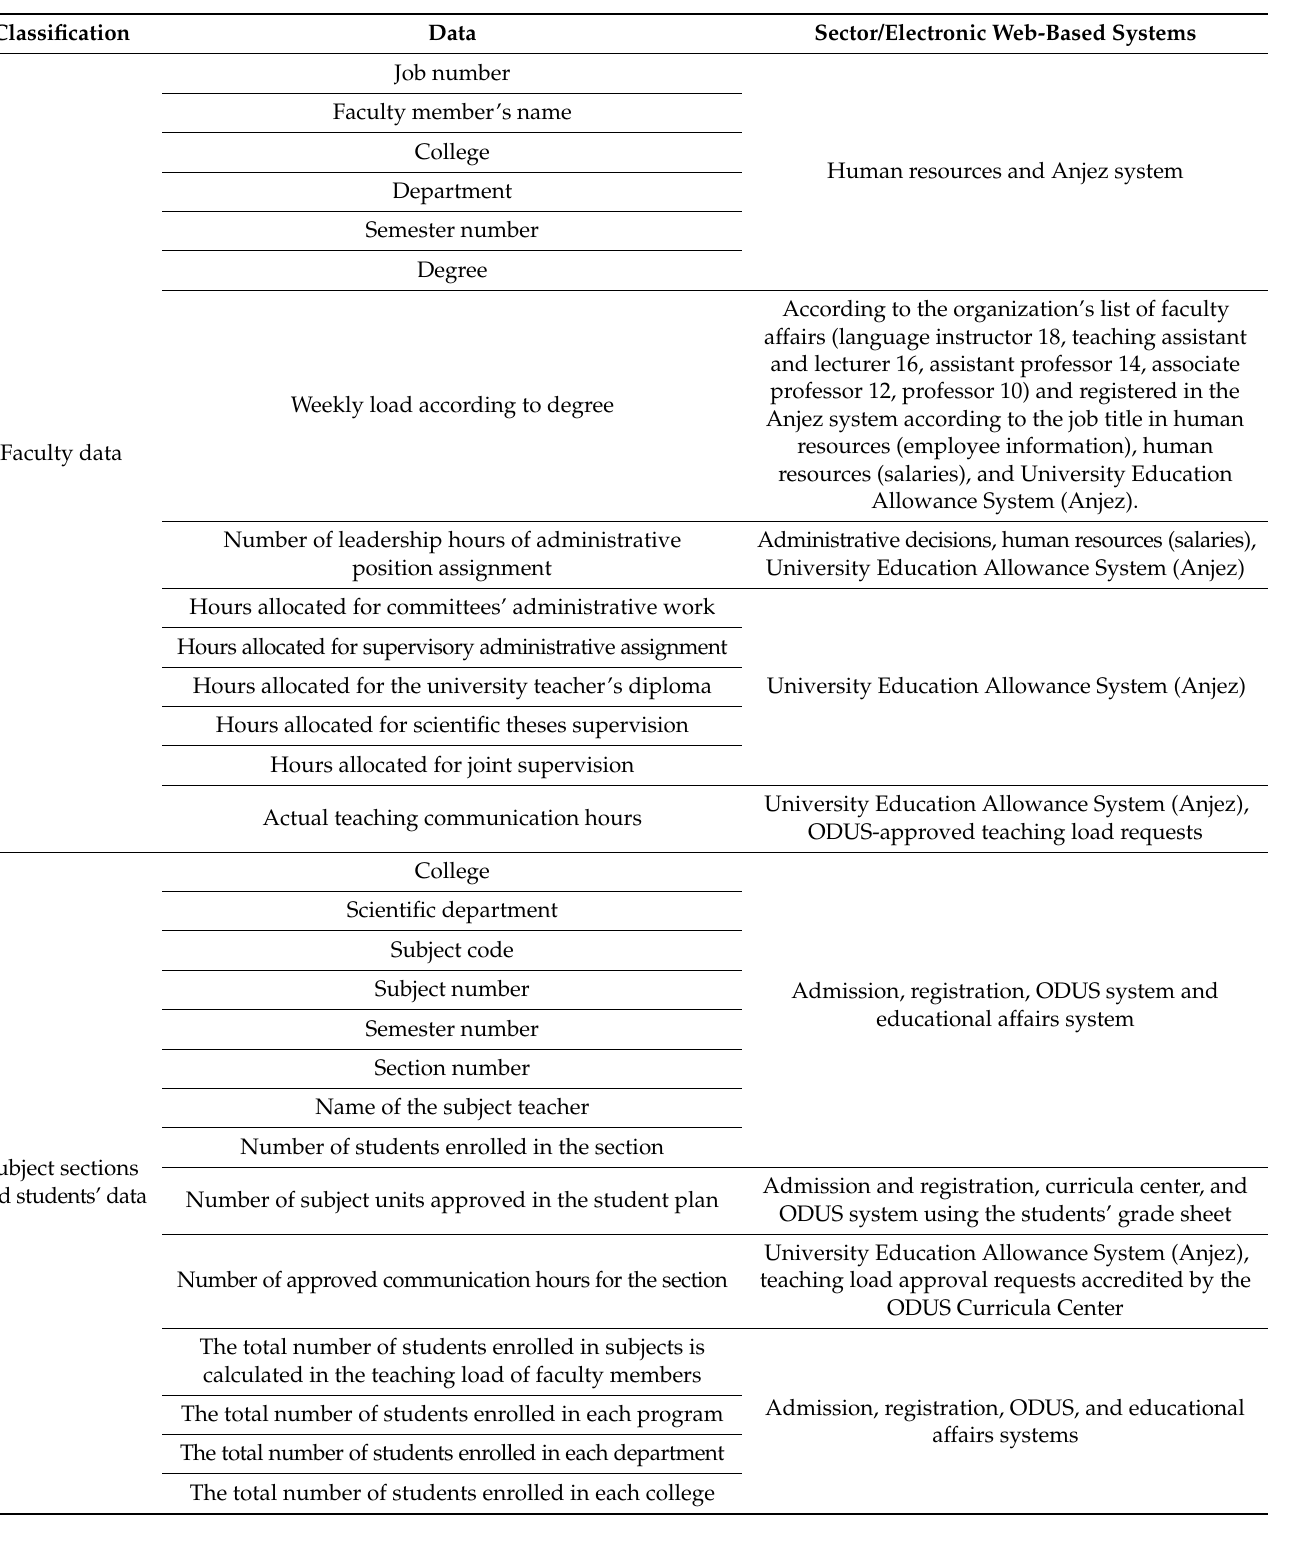
Table 1. Data required for streamlining and automating the framework and their respective